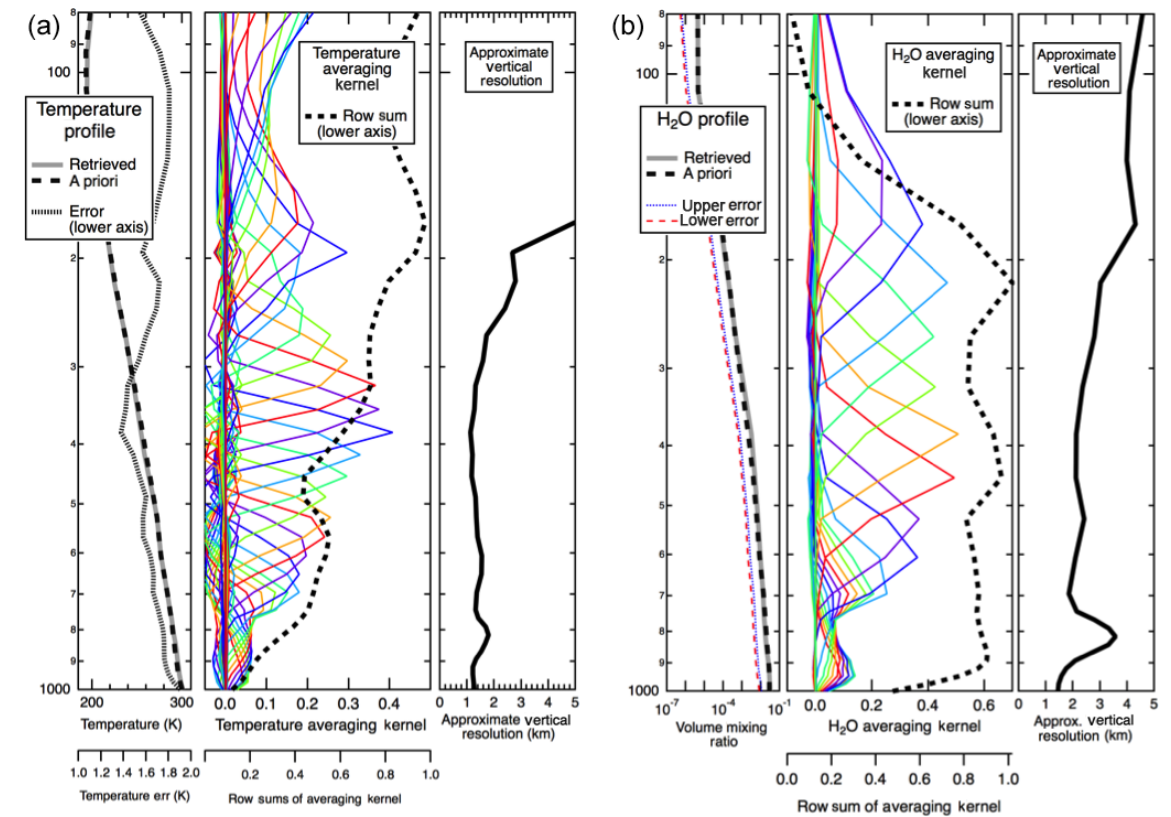
Figure 5. Sample retrieval profiles, errors, averaging kernels, row sums of the averaging kernels and approximate vertical resolutions for temperature (a) and water vapor volume mixing ratio (b) . Each colored line in the averaging kernel panels is from a partial row of the averaging kernel (e.g., the rows of ∂ ˆ T atm /∂ T atm and ∂ ln [ ˆ H 2 O ] /∂ ln [ H 2 O ] , as seen in Fig.